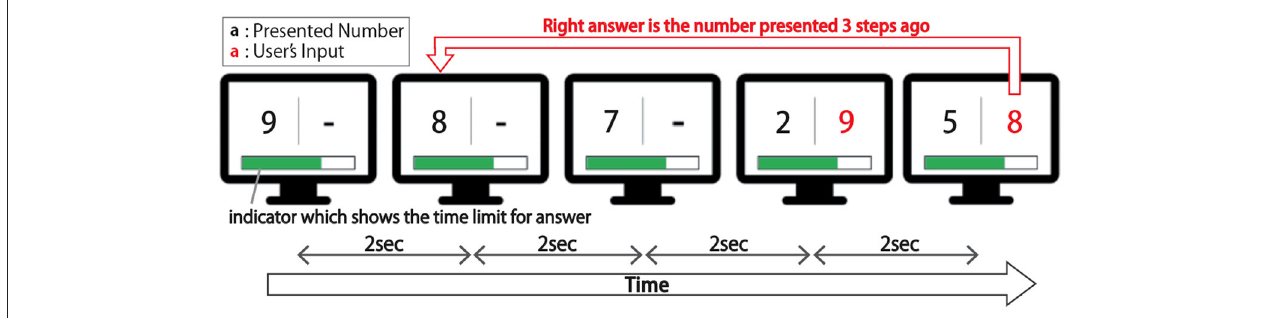
FIGURE 8 | Schema of the 3-back task. In this task, participants were presented with a sequence of numeric stimuli and asked to input the number presented three steps before using a keyboard.